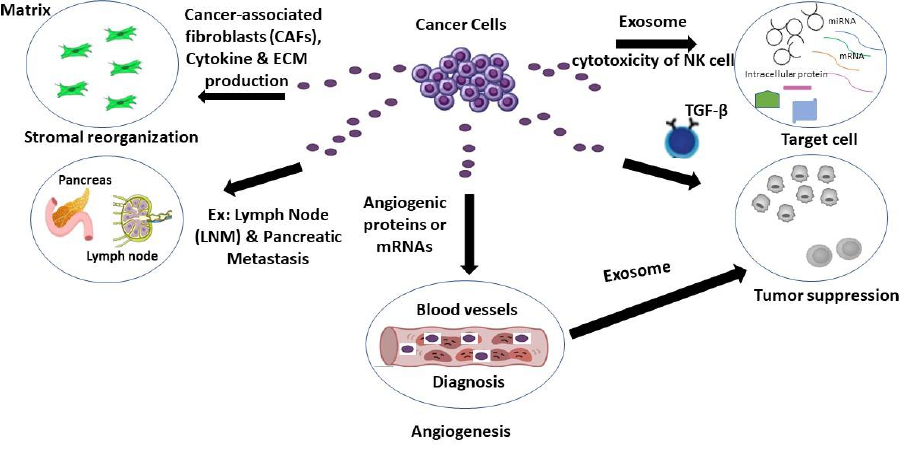
Figure 3. Cancer cells secrete exosomes which can promote metastasis, tumor suppression, cancer- associated fibroblast (CAF) formation, angiogenesis, and the secretion of cytokines. The biomarkers discovered from these exosomes may be useful in detecting various types/stages of cancer.